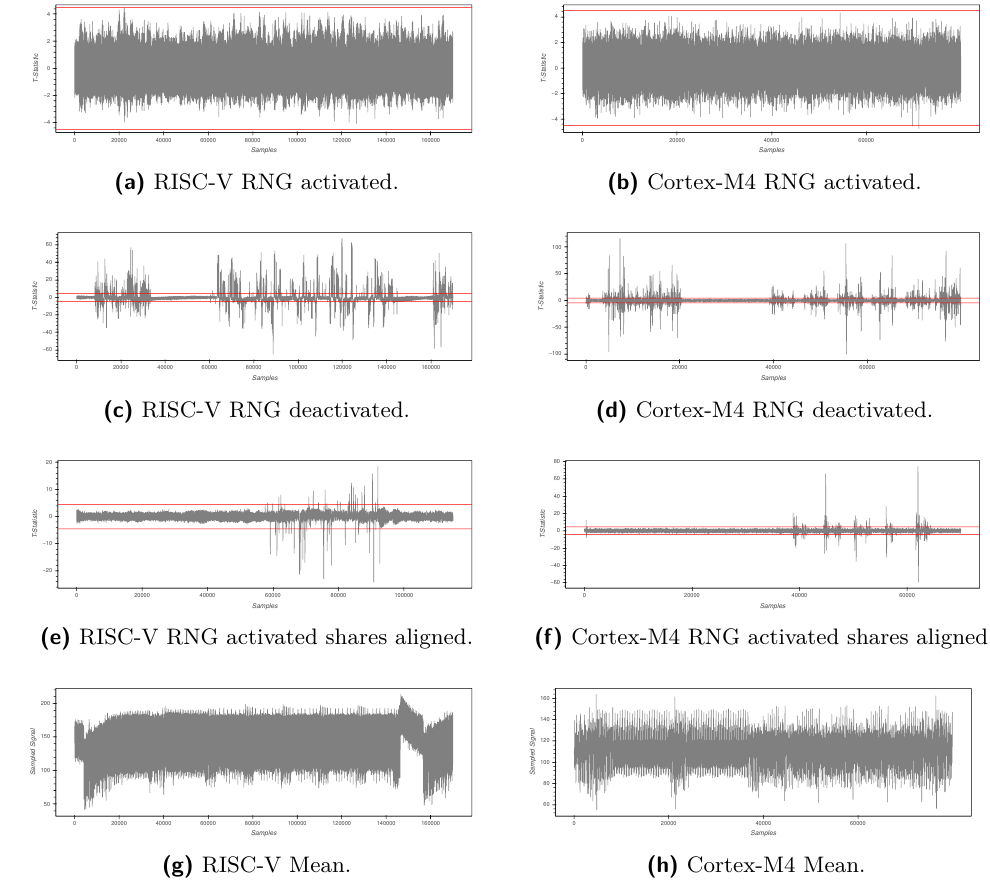
Figure 7: First-order t-test results of a Keccak - f [800] round. The ± 4 . 5 threshold is marked by red lines. Experiments with RNG active use 1M traces, with RNG inactive use 10k traces, and with aligned share evaluations use 100k